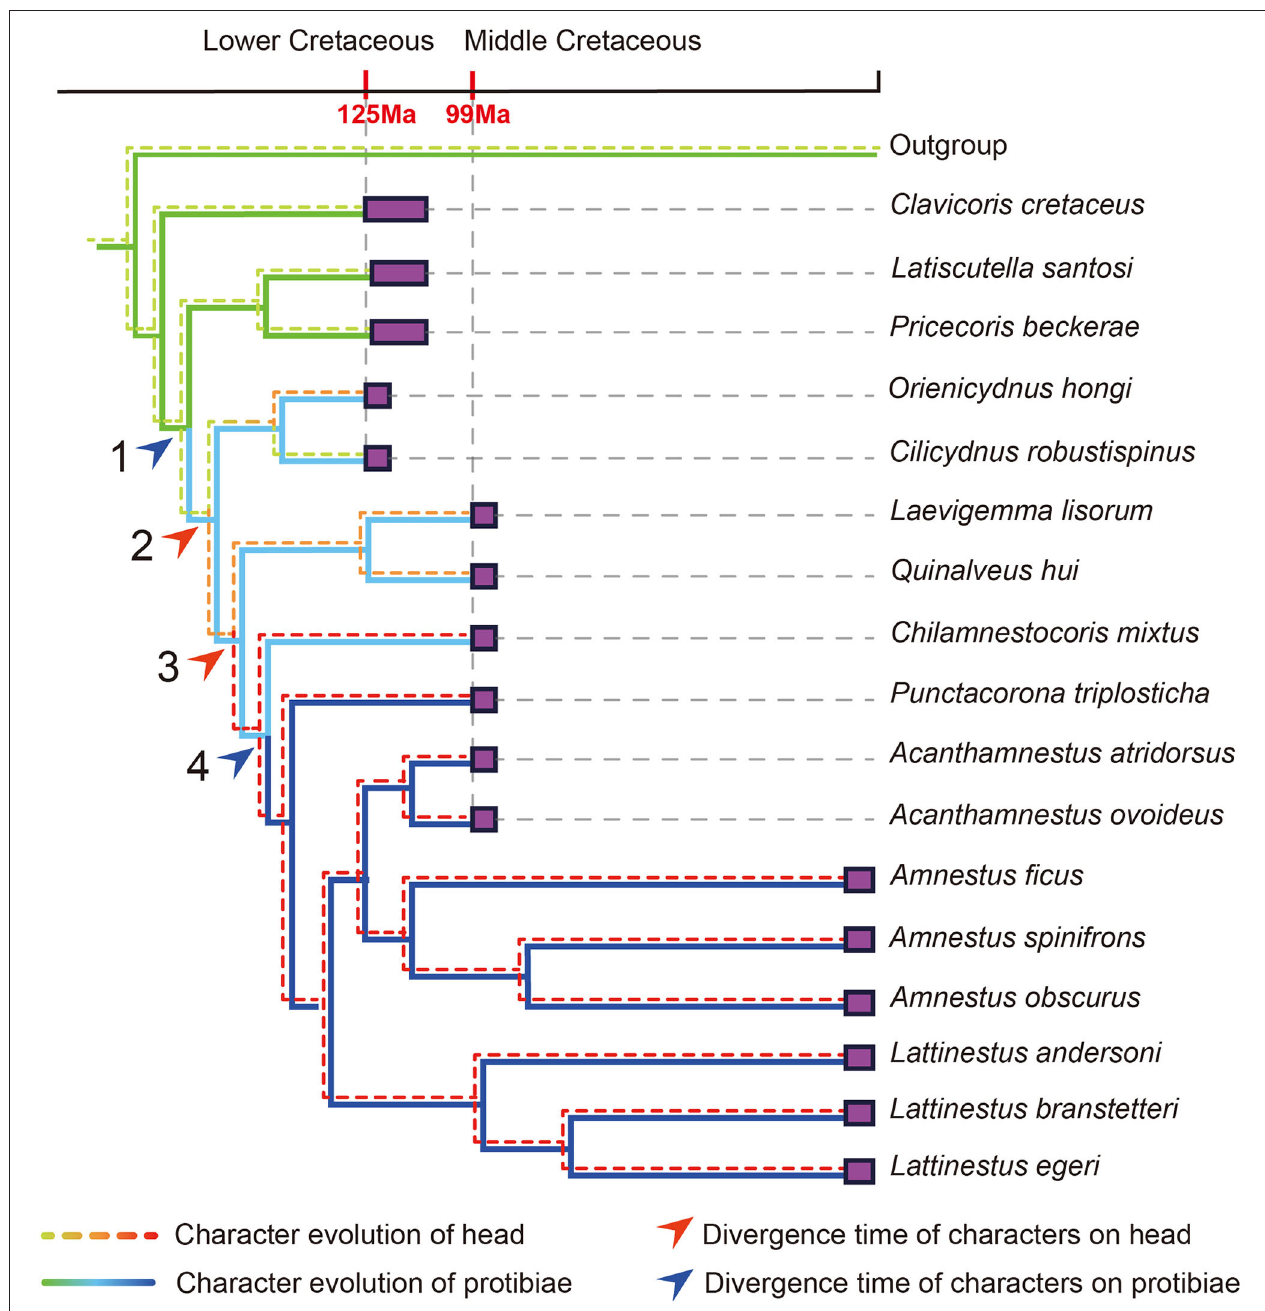
FIGURE 11 | Phylogeny of subfamily Amnestinae, including fossil species and two extant genera. Reconstructions of character evolution derived from phylogenetic analysis. At the top are geological periods calibrated to a time scale; arrows indicate the divergence time of characters on head and protibiae; purple blocks represent the occurrence time of species. Branches are color coded to represent the evolution of different head and protibial characters (see legend; see also Supplementary Figure S1 ).